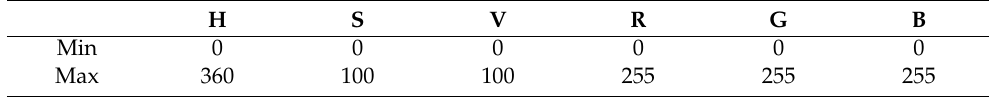
Table 2. Color space of HSV and